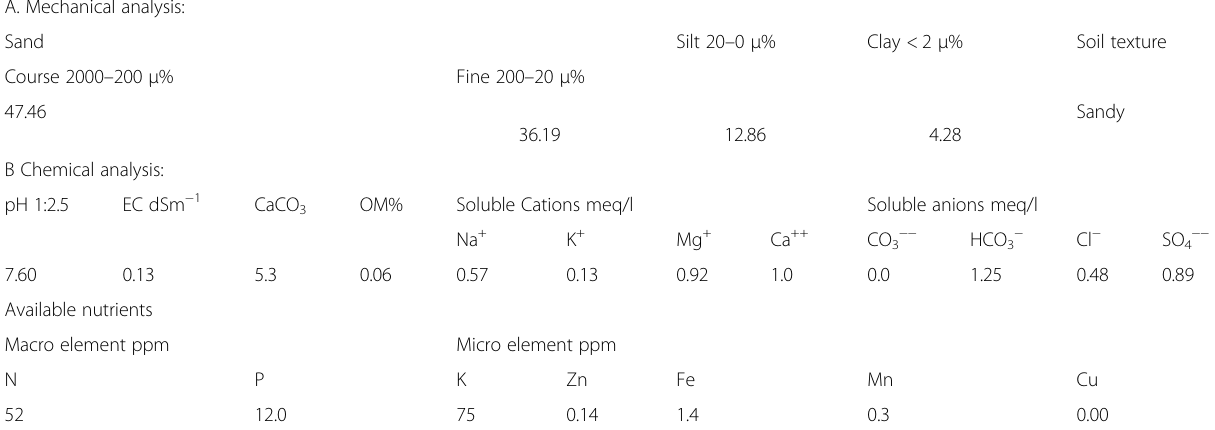
Table 1 Mechanical and chemical analysis of the experimental soil